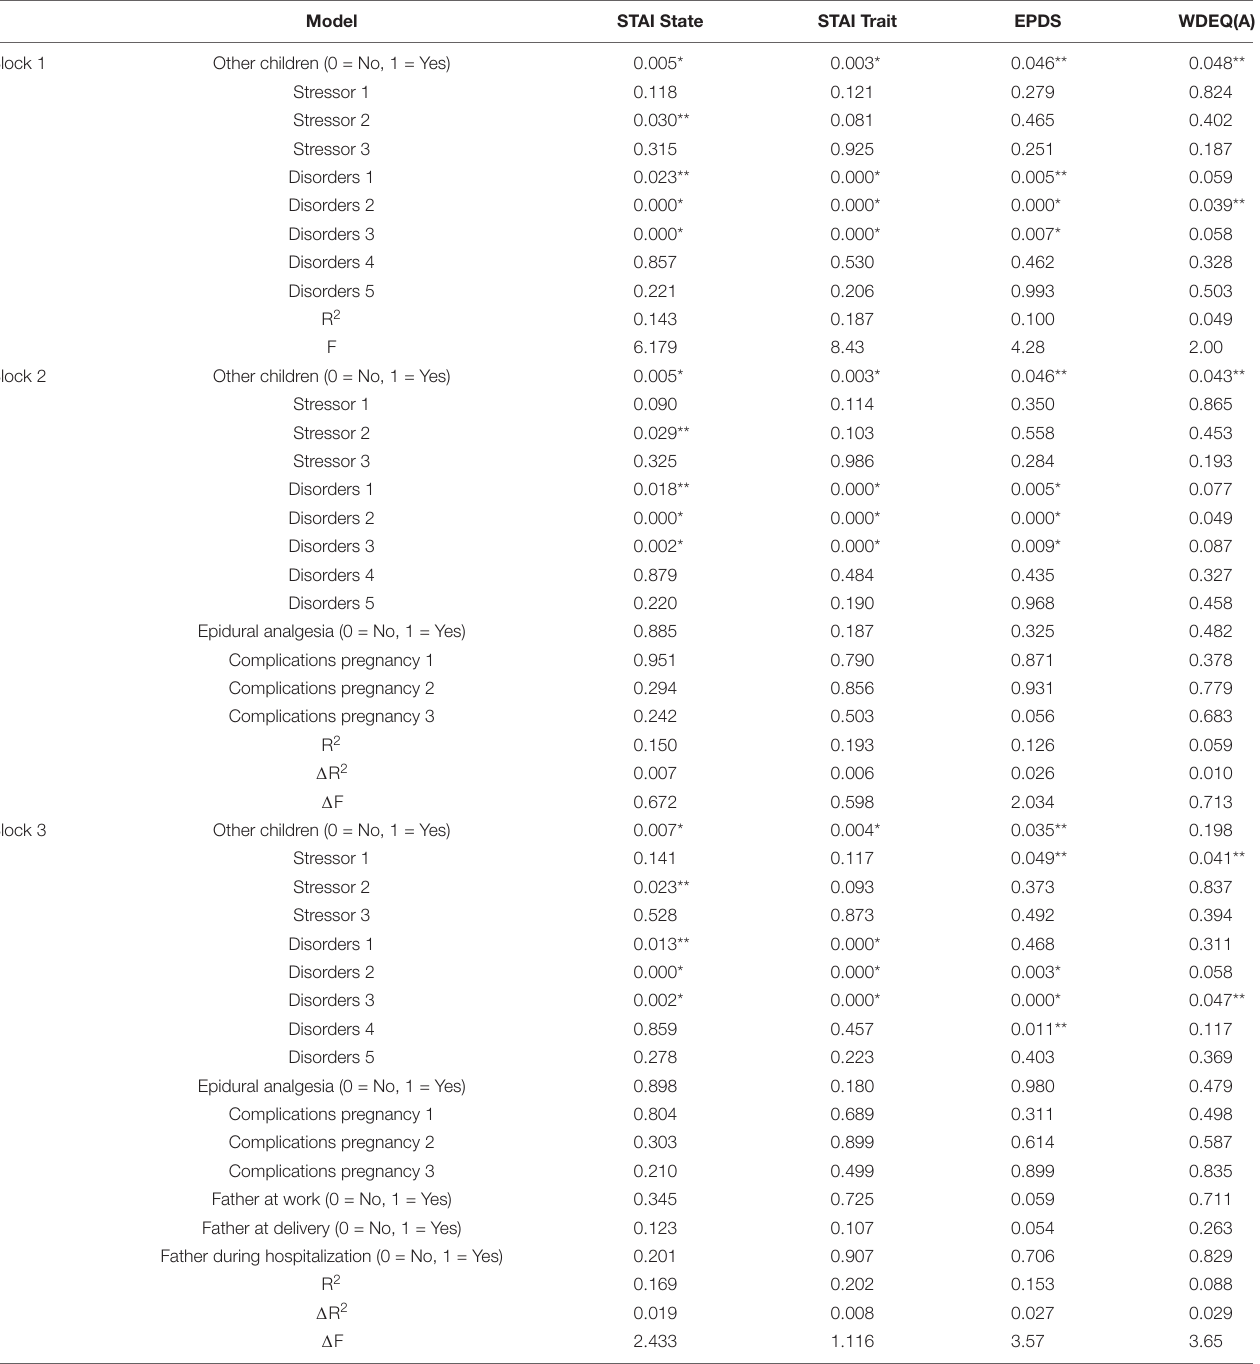
TABLE 2 | Pregnant women–Hierarchical Regression Analyses for STAI State, STAI Trait, EPDS, and WDEQ(A). Model STAI State STAI